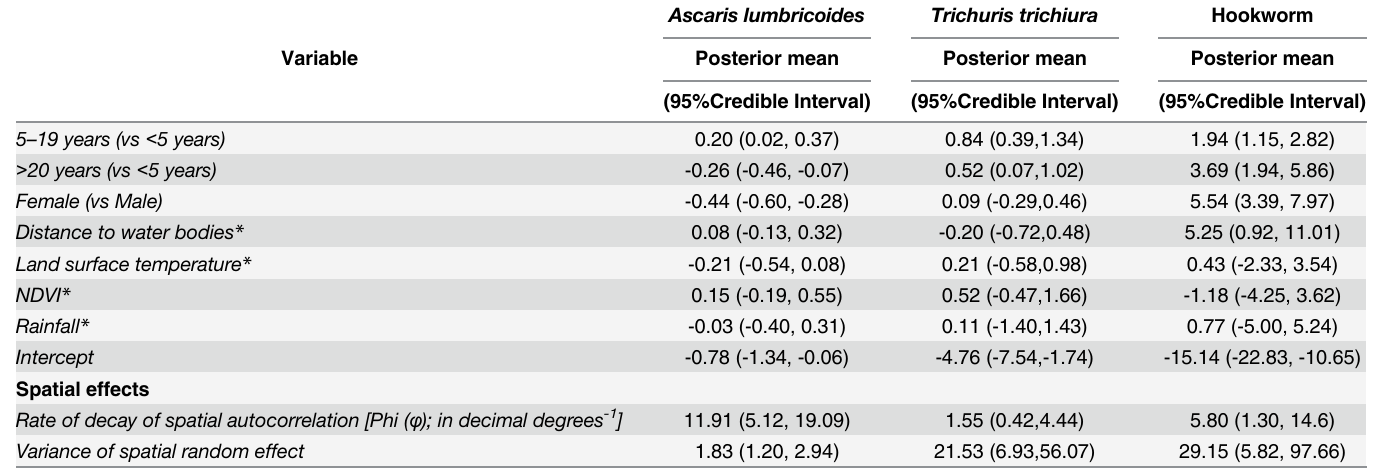
Table 2. Estimates of model parameters (in the log odds scale) for STH prevalence in Luzon and Visayas, Philippines, based on Bayesian geosta- tistical logistic regression models.